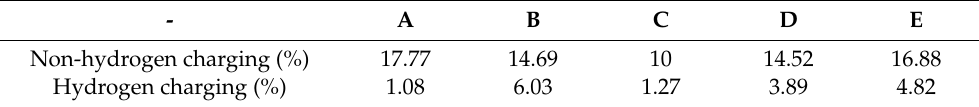
Table 4. RA of different samples.